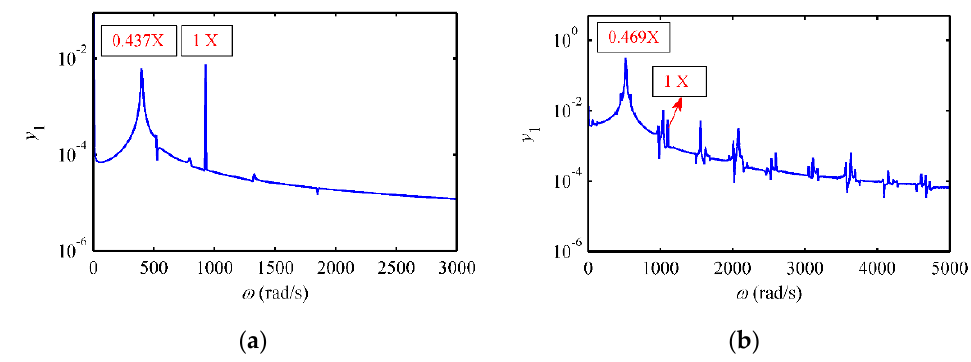
Figure 3. Frequency spectrums of y 1 of original system for the oil whirl region at ( a ) ω = 915 rad/s, ( b ) ω = 1100